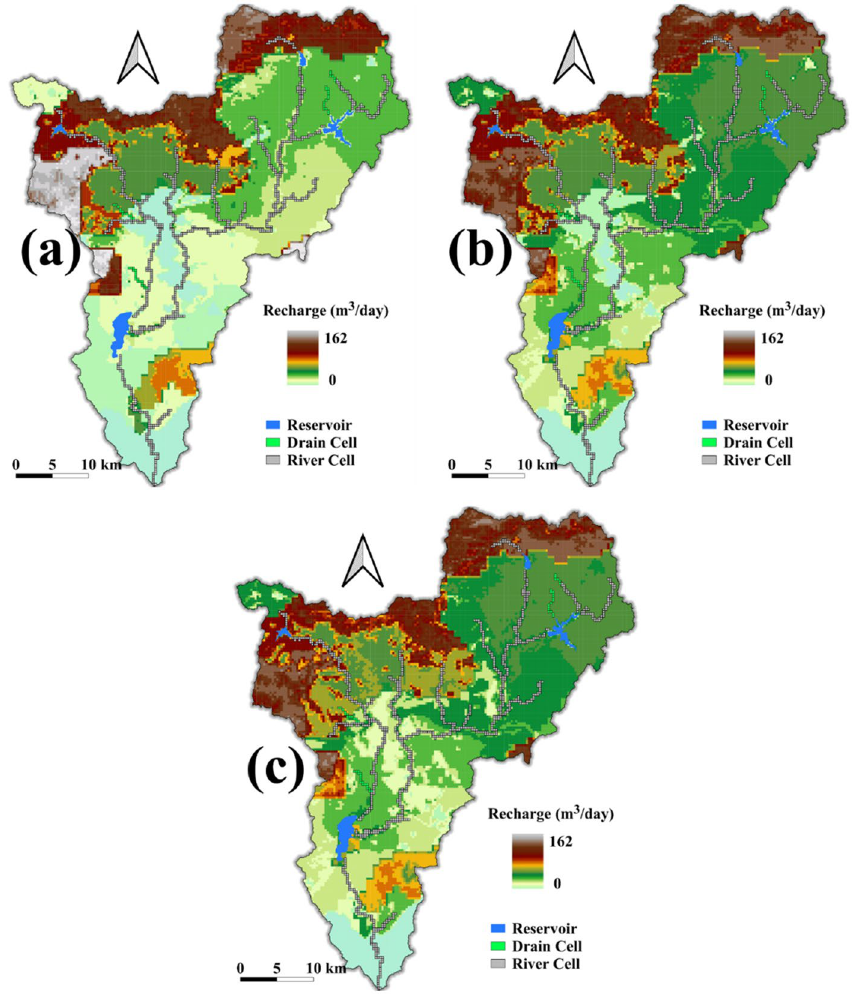
Figure 11. Spatial distribution of average groundwater recharge under baseline ( a ), scenario 2 ( b ), and scenario 4 ( c ) in the study area from SWAT-MODFLOW 44 output prepared using QSWATMOD2 (https:// swat. tamu. edu/ softw are/ swat- modfl